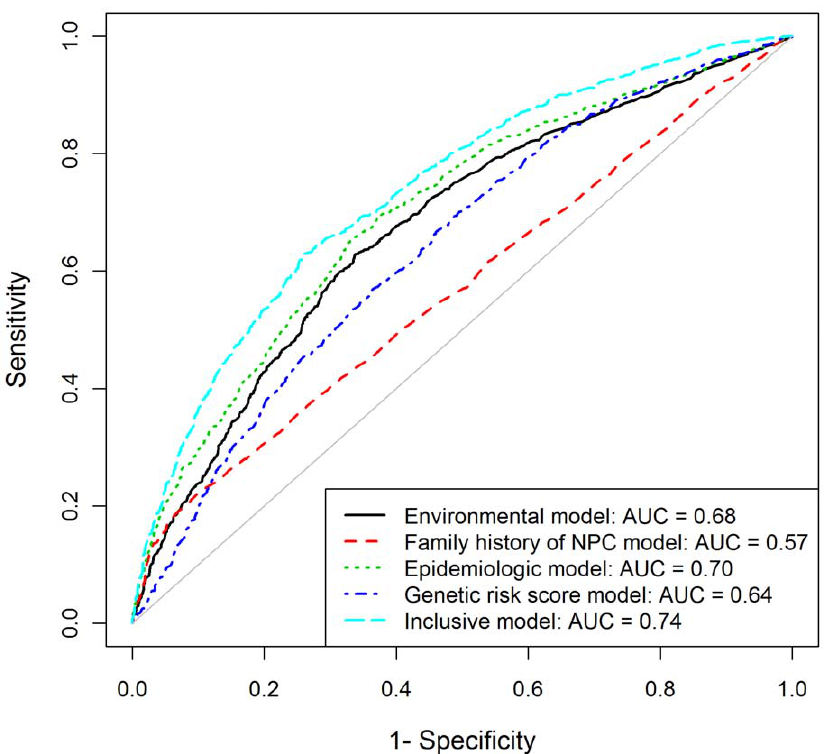
Figure 3. Receiver-operating characteristic (ROC) analysis. The areas under the ROC curves (AUC) as measures of predictive power for risk- assessment models based on environmental risk factors, family history of NPC, and genetic variants for NPC.